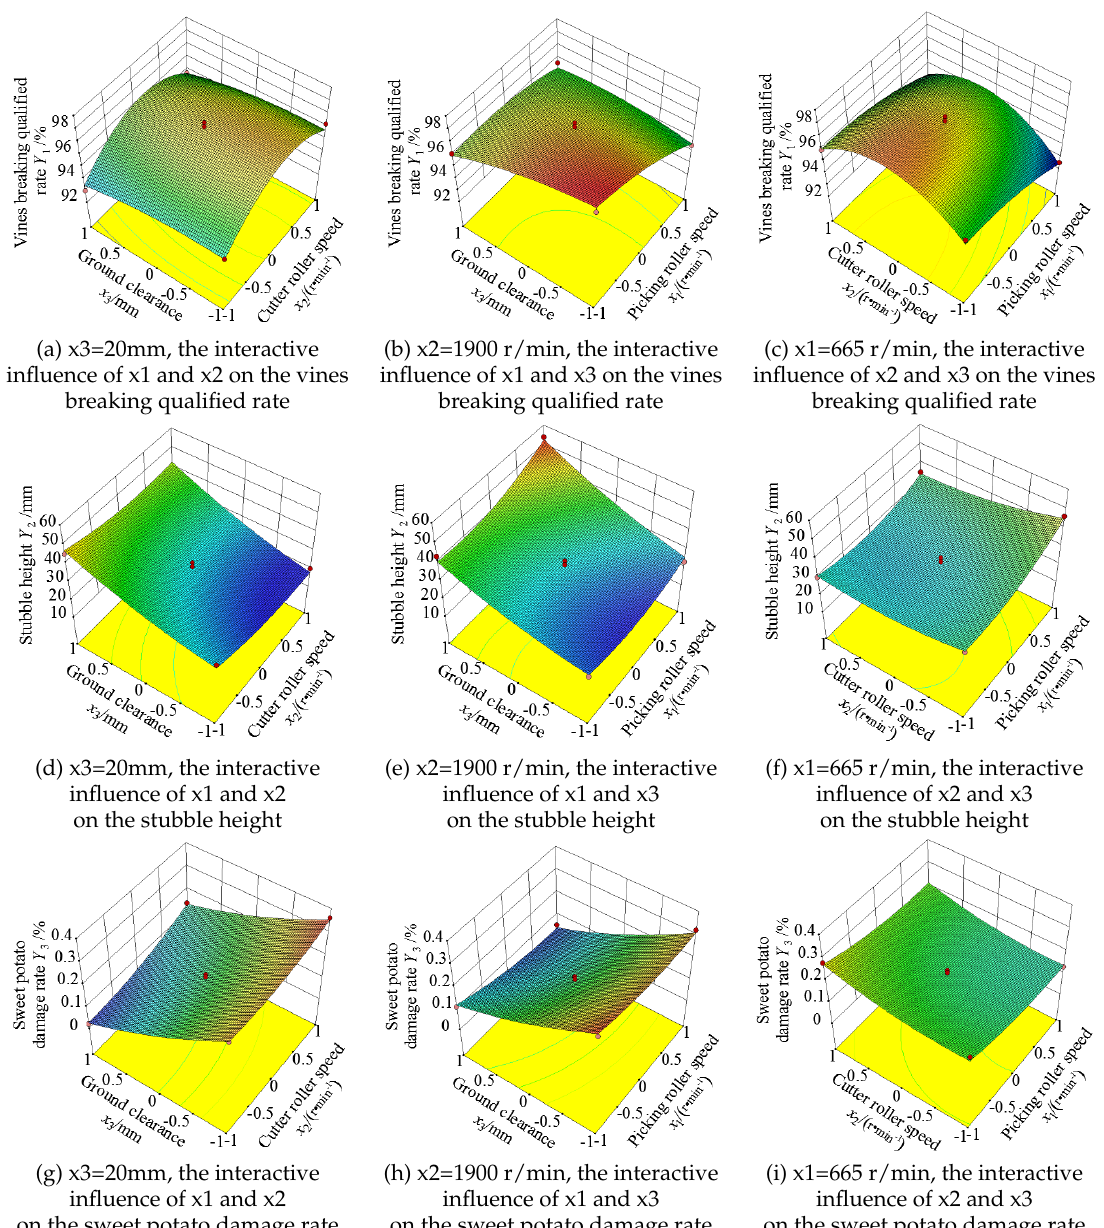
Fig. 11. The influence of interaction factors on the response